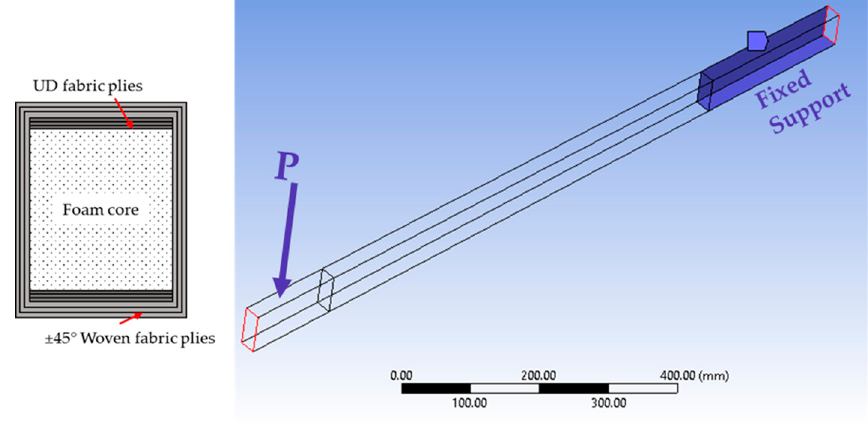
Figure 5. Materials configuration sketch and computational model for the aileron main beam.